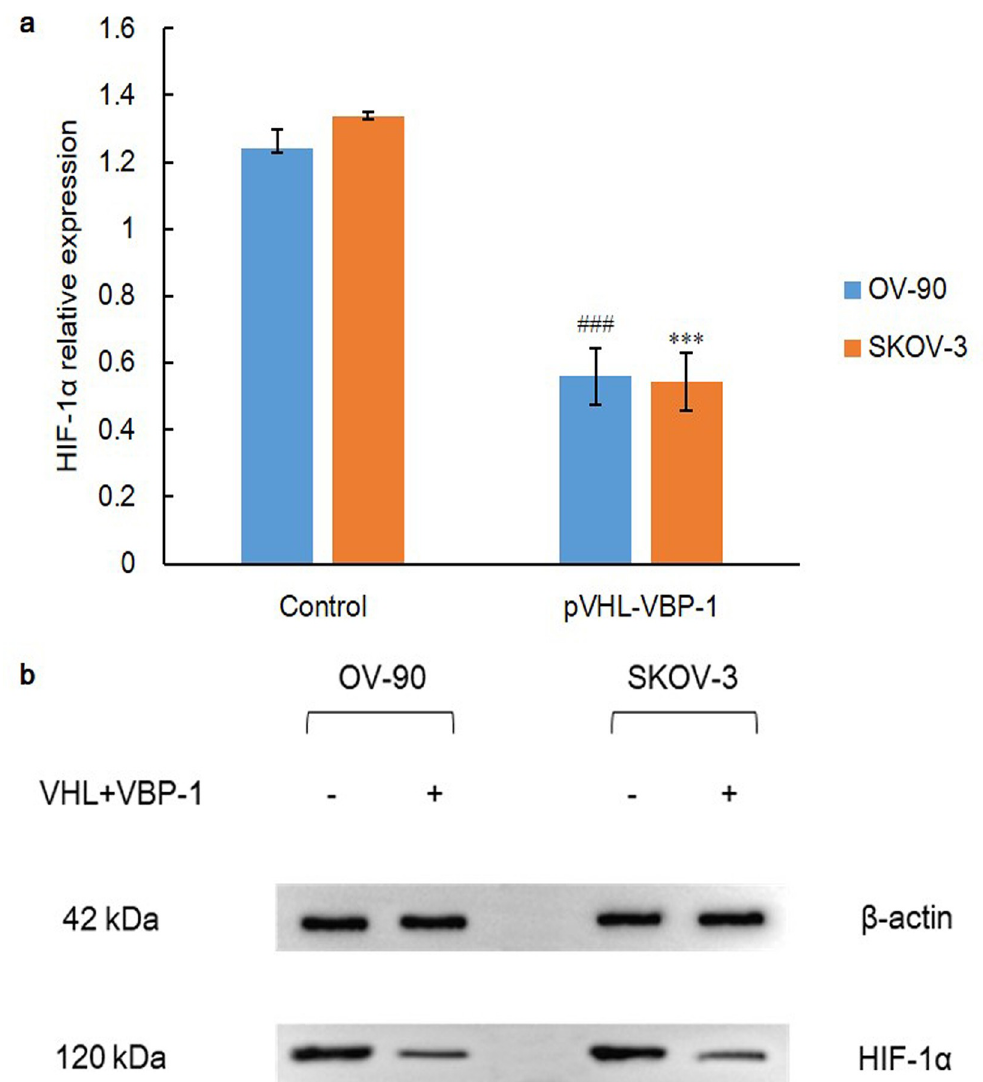
Fig 9. HIF-1 α expression after plasmids transfection for 48 h. A) Over-expression of pVHL-VBP-1 inhibits protein expression of HIF-1 α in OV-90 and SKOV-3 ovarian cancer cell lines. Data are shown as mean ± SD of at least three individual experiments. ( � P < 0.05, �� P < 0.01, ��� P < 0.001 vs. SKOV-3 control; # P < 0.05, ## P < 0.01, ### P < 0.001 vs. OV-90 control). B) The expression of HIF-1 α was assessed by western blot analysis after transfection of plasmids of VHL and VBP-1 for 48 h. The equal protein loading is shown by detection of β -actin. The figures show representative blots which were cropped from original images. with up-regulation of glucose transporters and glycolytic enzymes seen in glycolysis and lactate production, particularly LDH [42, 48]. Lactate, a final product of anerobic glycolysis, accumu- lates intracellularly owing to blocking of the tricarboxylic acid (TCA) cycle and increased expression of LDH. HIF binds to HRE region on the promoter of LDH and catalyzes pyruvate into lactate, which augments the effect of pyruvate dehydrogenase kinase 1 (PDK-1) on further impeding the conversion of pyruvate into acetyl-CoA for entry into the TCA cycle [42]. Mono- carboxylate transporter (MCT) is closely related to lactate-induced HIF-1 activation, which promotes the rate of lactate shuttling [49]. HIF-1 α expression also induces upregulation of